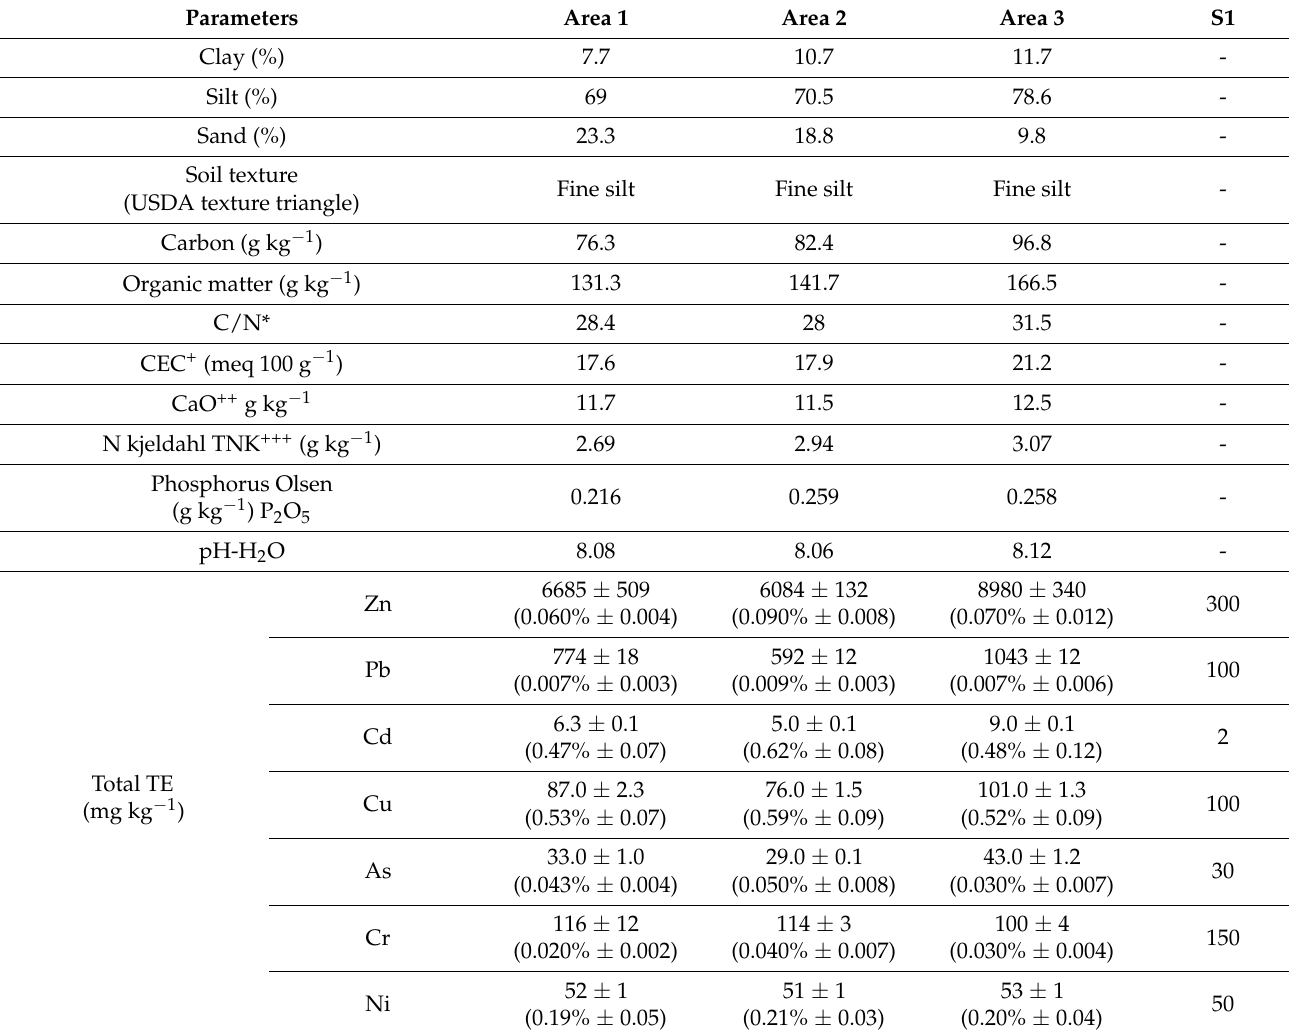
Table 1. Main physico–chemical properties, total, and NH 4 NO 3 extractable (% of total, expressed between parenthesis) concentrations of trace elements (TE) in the sediment of the field site for each area and TE threshold values (S1) for sediment management. TE concentrations are expressed in mg kg − 1 dry sediment (DS). Values are means ± SD.